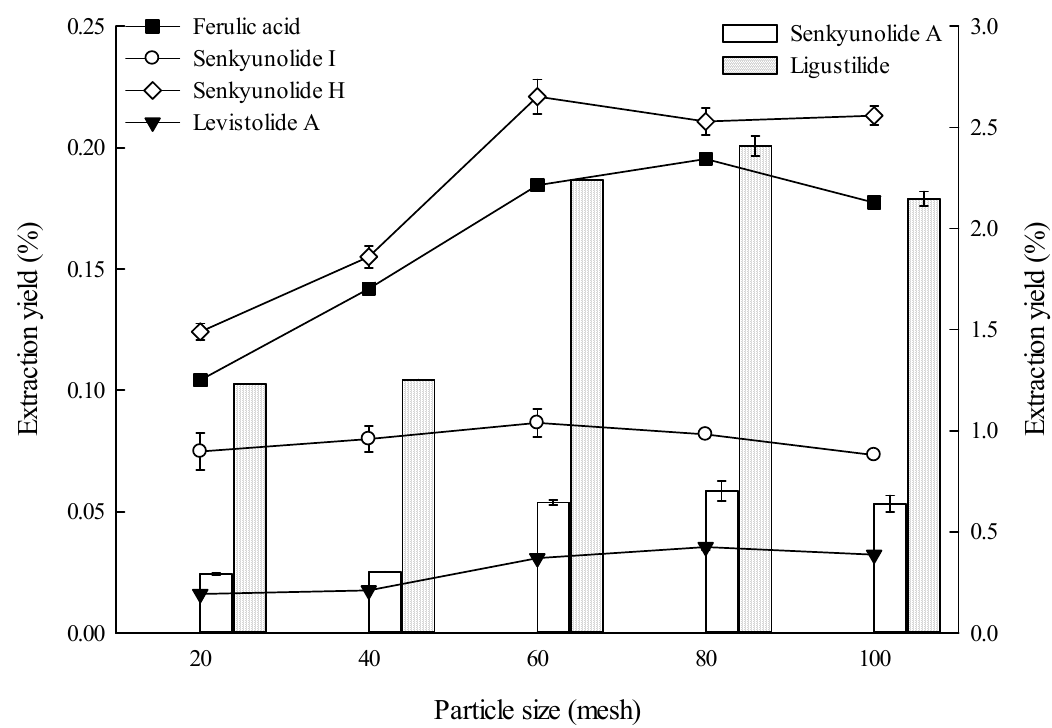
Figure 3. Effects of particle size on the extraction yields of the six constituents (the lines and bar graphs are referenced to the left and right axes, respectively).